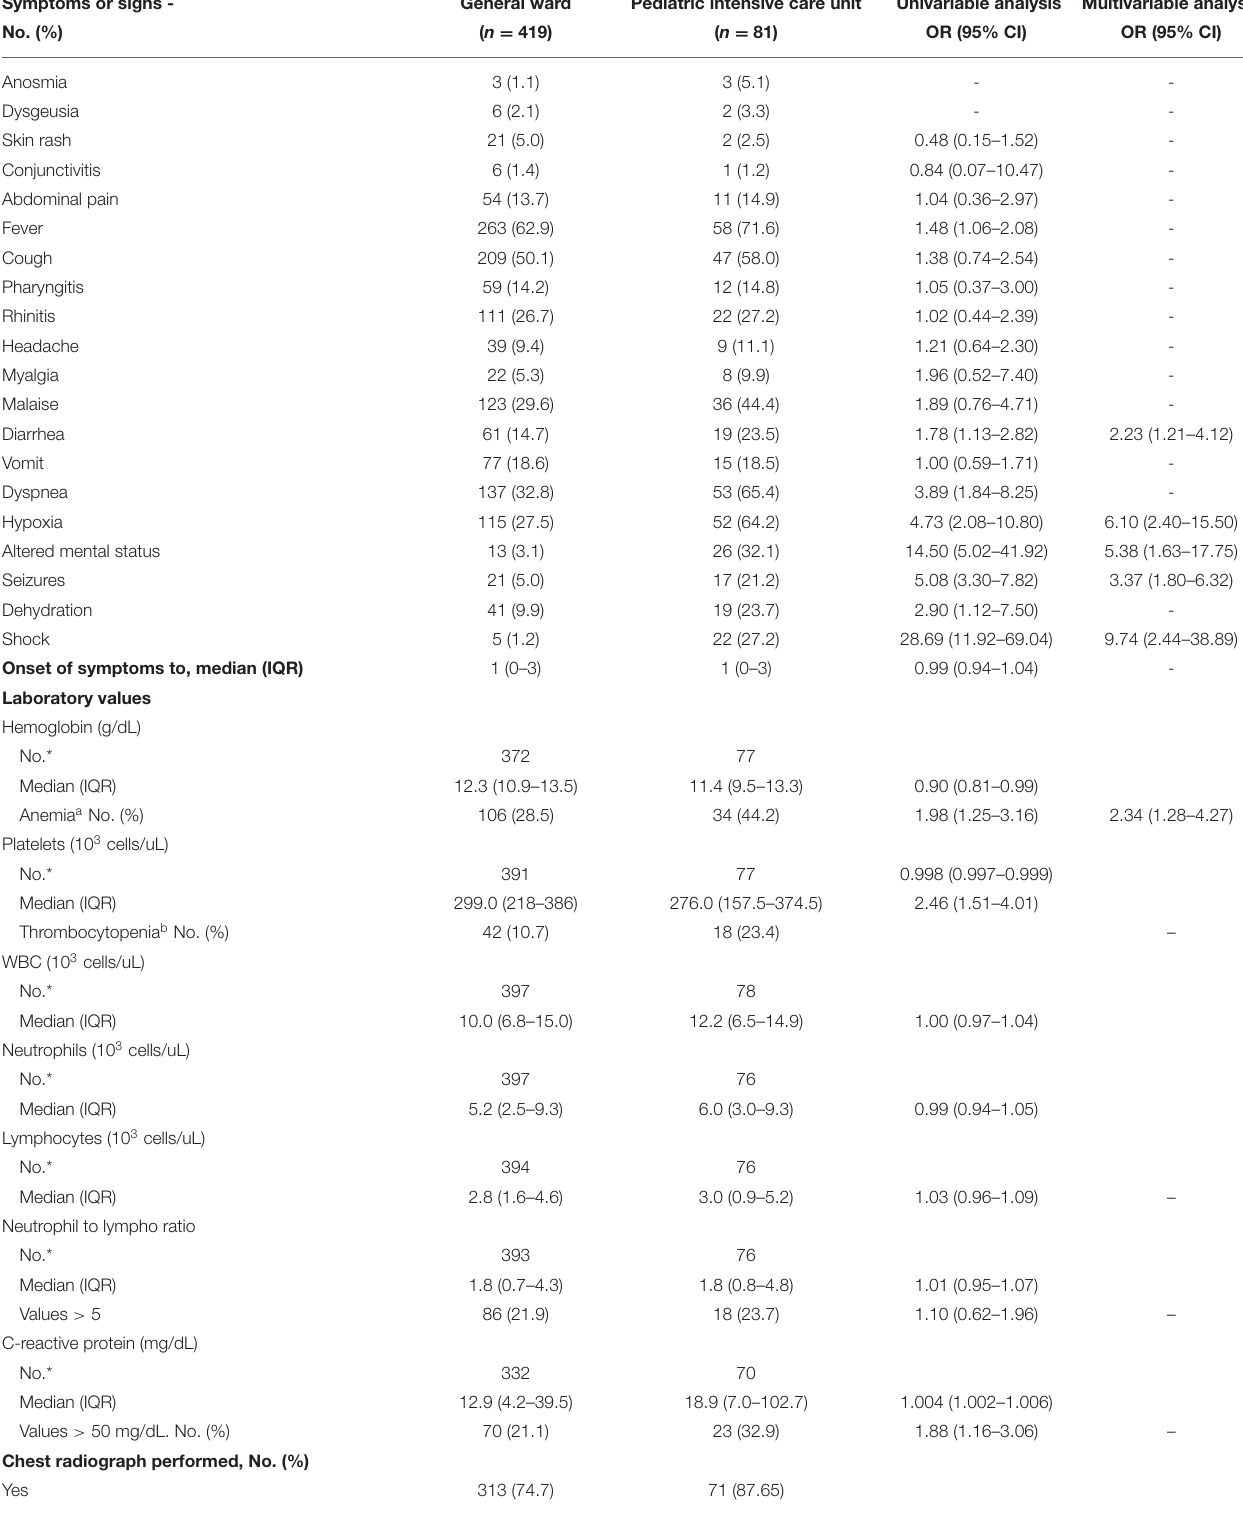
TABLE 5 | Signs or symptoms, laboratory values and chest radiograph findings described or present on initial evaluation associated with intensive care, among pediatric patients hospitalized due to COVID-19 using multiple imputation chained equations for missing data. Symptoms or signs - General ward Pediatric intensive care unit Univariable analysis Multivariable